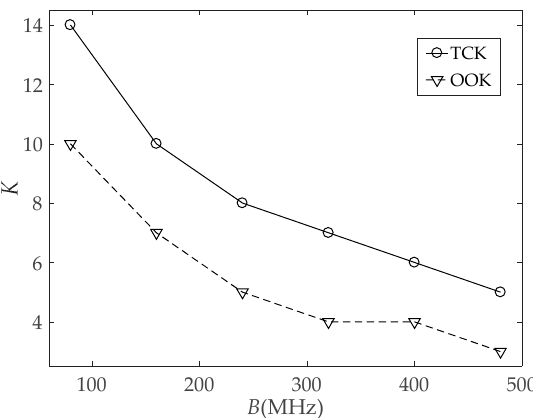
Figure 10. Bu ff er capacity K versus receiver bandwidth B Figure 10. Buffer capacity K versus receiver bandwidth B .